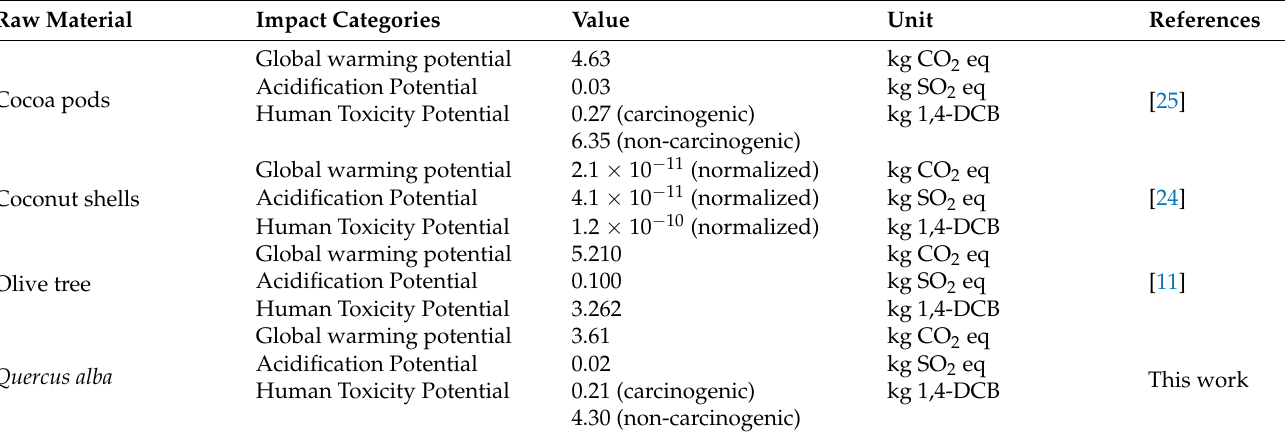
Table 4. Comparison of environmental impacts with existing